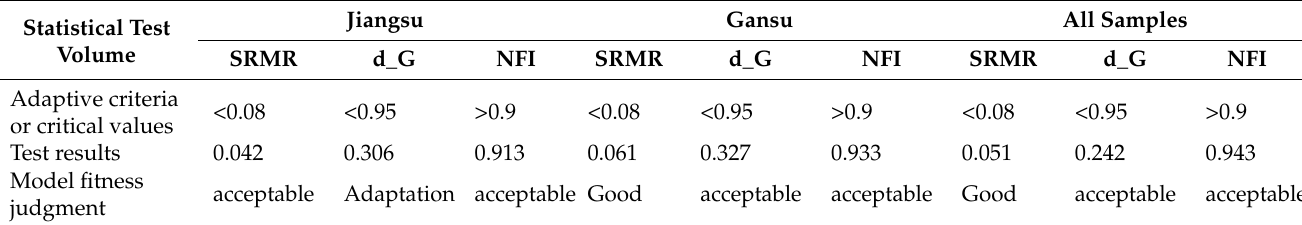
Table 5. Fitting results of the